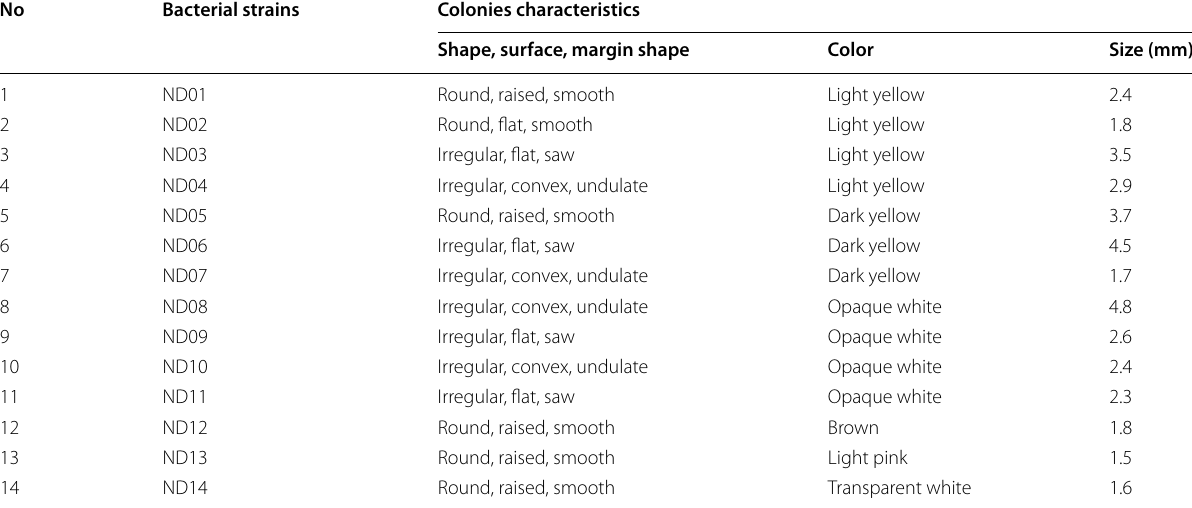
Table 2 Number and morphology characteristics of endophytic bacteria recovered on the TSA media from rice root No